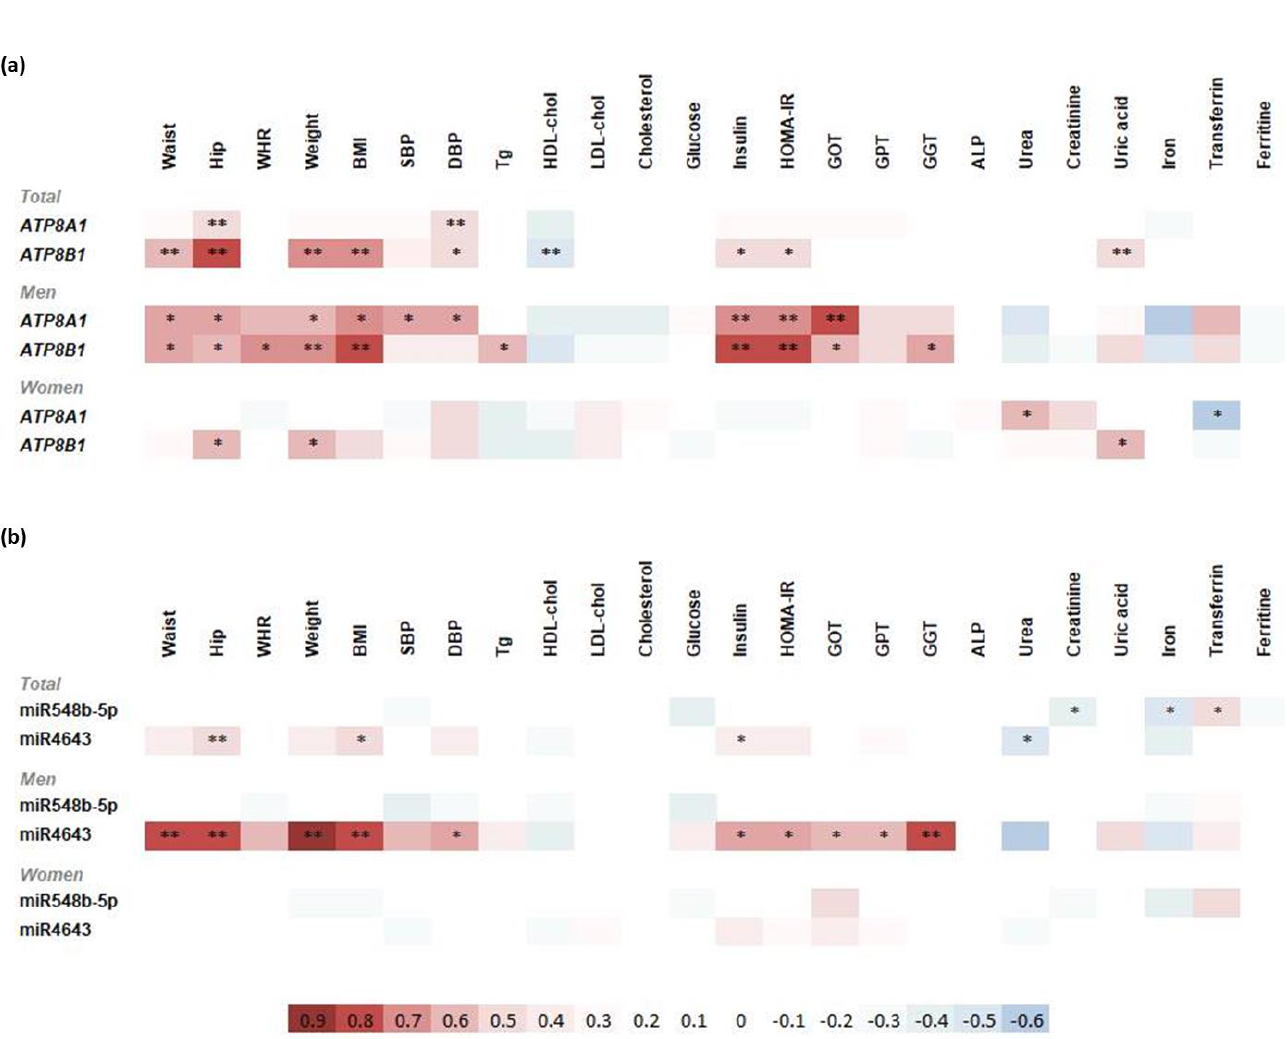
Figure 2. Spearman correlation analysis: ( a ) correlations between clinical/metabolic parameters and P4-ATPase gene expression levels; ( b ) correlations between clinical/metabolic parameters and miR expression levels. Spearman correlation analysis was performed. * p < 0.05, ** p < 0.01.